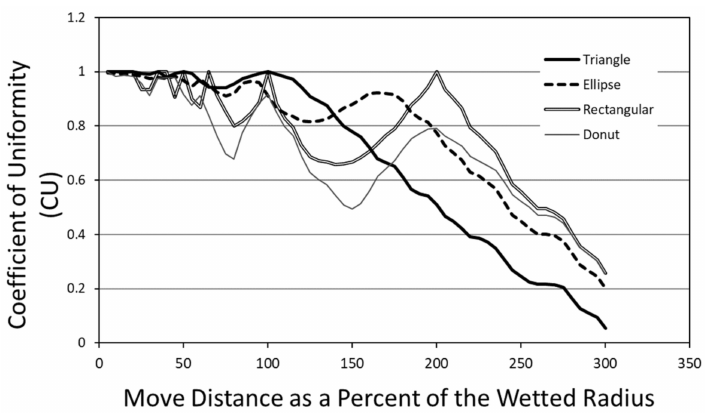
Figure 7. Distribution uniformity (DU) for triangular, ellipse, rectangular, and donut application patterns as a move distance as a percent of the wetted radius.